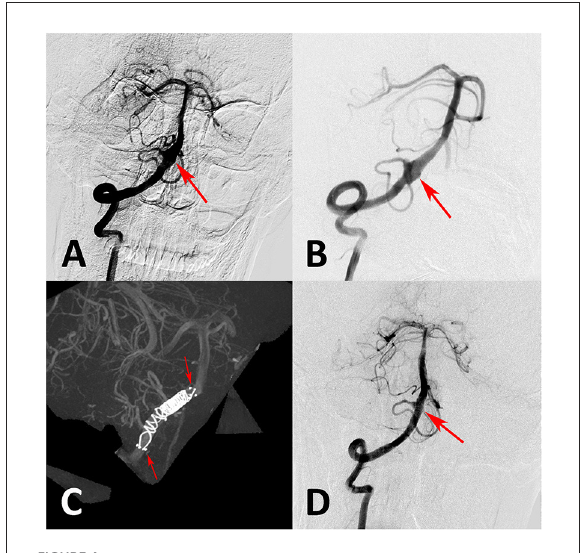
FIGURE4 (A) Preoperative angiography showed an unruptured vertebral artery fusiform aneurysm. (B) Immediate angiography after stenting showed aneurysm persisted. (C) Overlapping stent technique with double conventional stents showed in intraoperative angiography. (D) Follow-up angiography at 6 months showed aneurysm occlusion